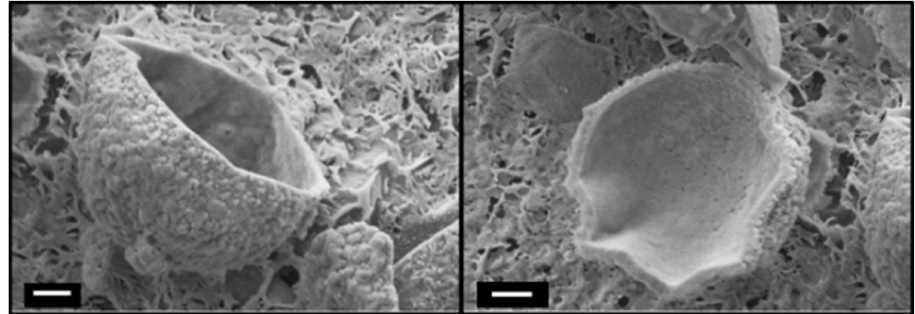
Figure 4. Cryo-SEM images of the PGMA- b -Ru(bpy) 3 - b -PHPMA triblock copolymer vesicles in a water / methanol solution (scale bar = 1 µ m).